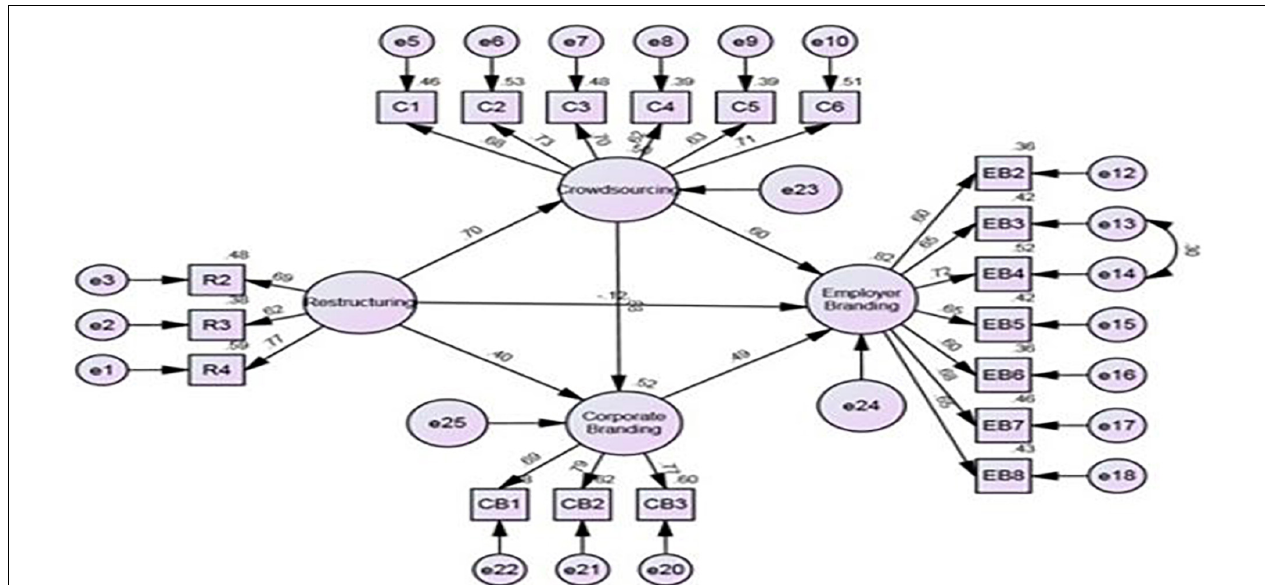
FIGURE 2 | SEM (standard estimates).